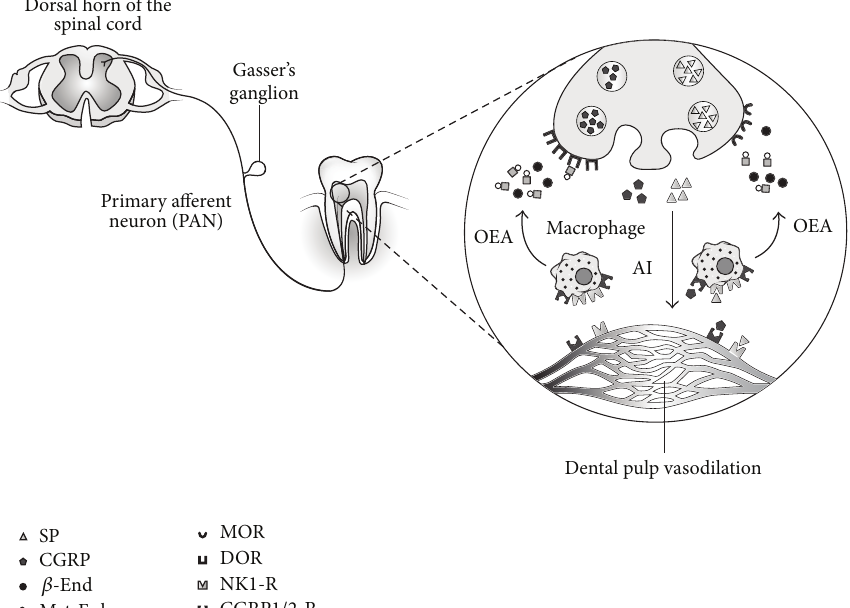
Figure 1: Proposed relationship between neurogenic inflammatory and endogenous opioid analgesic mechanisms. SP: substance P, CGRP: calcitonin gene-related peptide, 𝛽 -End: 𝛽 -endorphin, Met-Enk: methionine-enkephalin, NK1-R: neurokinin 1 receptor, CGRP1/2- R: calcitonin gene-related peptide receptors 1 and 2, MOR: 𝜇 -opioid receptor, DOR: 𝛿 -opioid receptor, OEA: opioid endogenous analgesia, AI: asymptomatic inflammation, and PAN: primary afferent